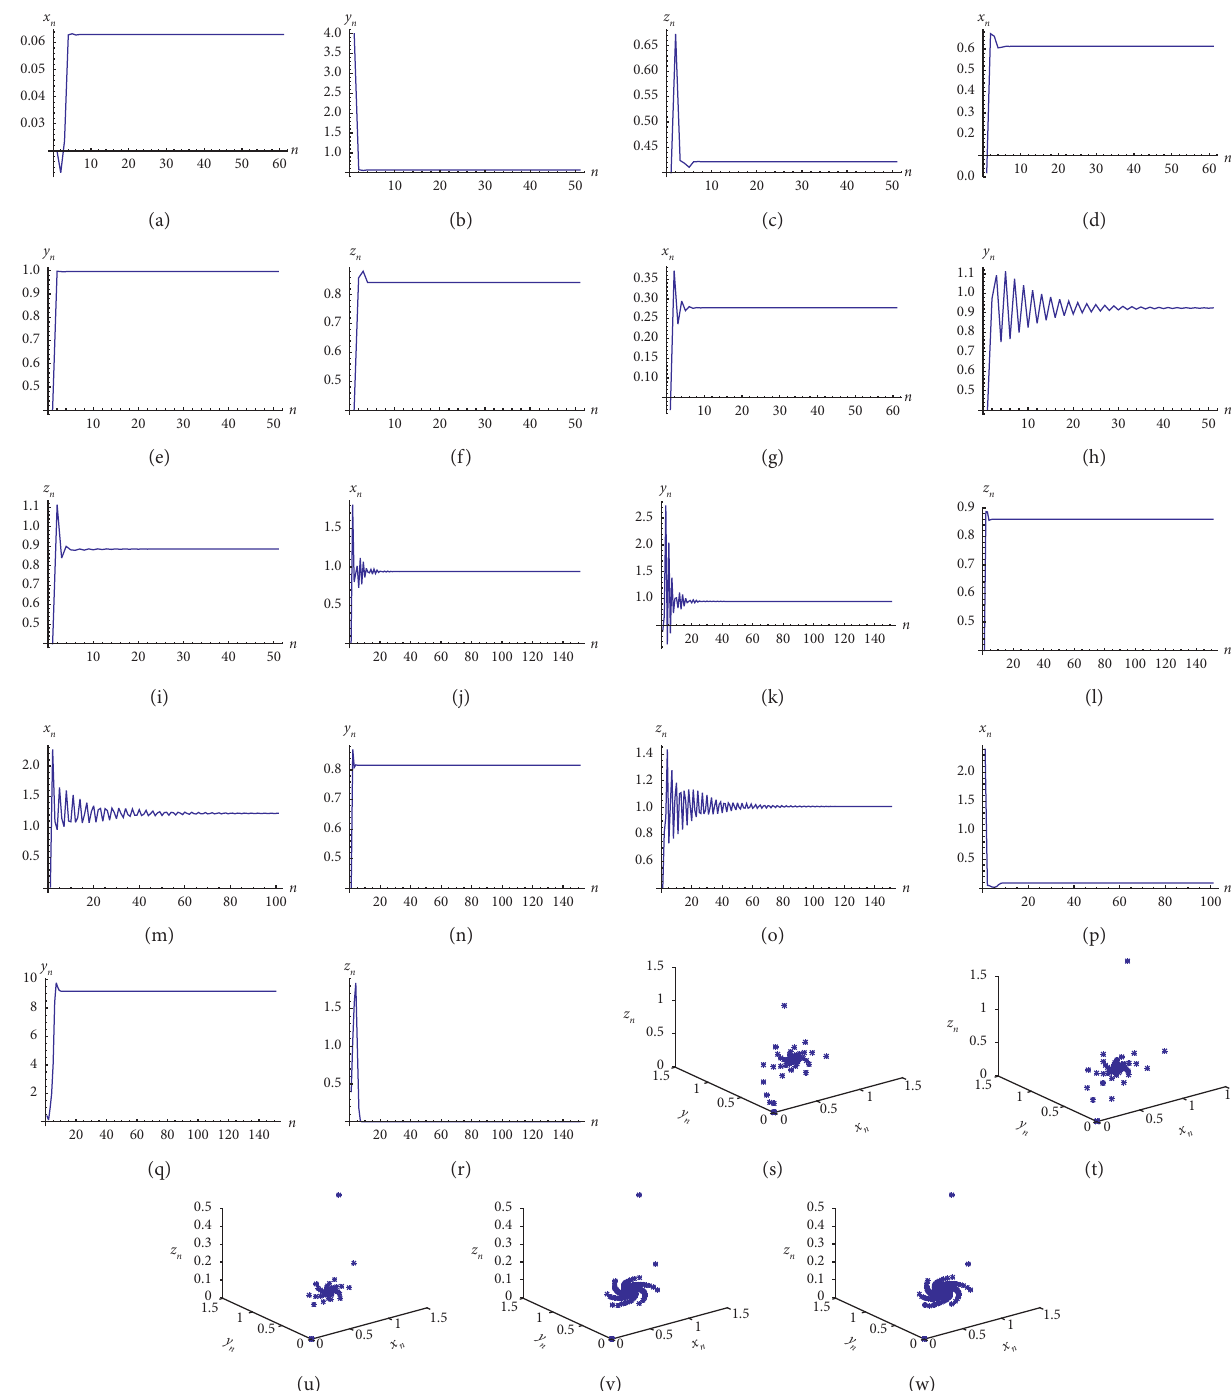
Figure 1: Trajectories for (3) to (8) with initial values x